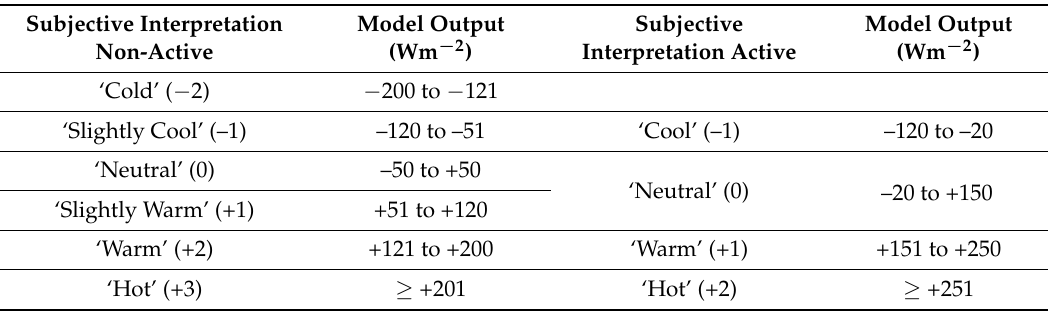
Table 1. Subjective interpretation of the COMFA human energy budget model output values for a non-active and active individual [48,50,54].